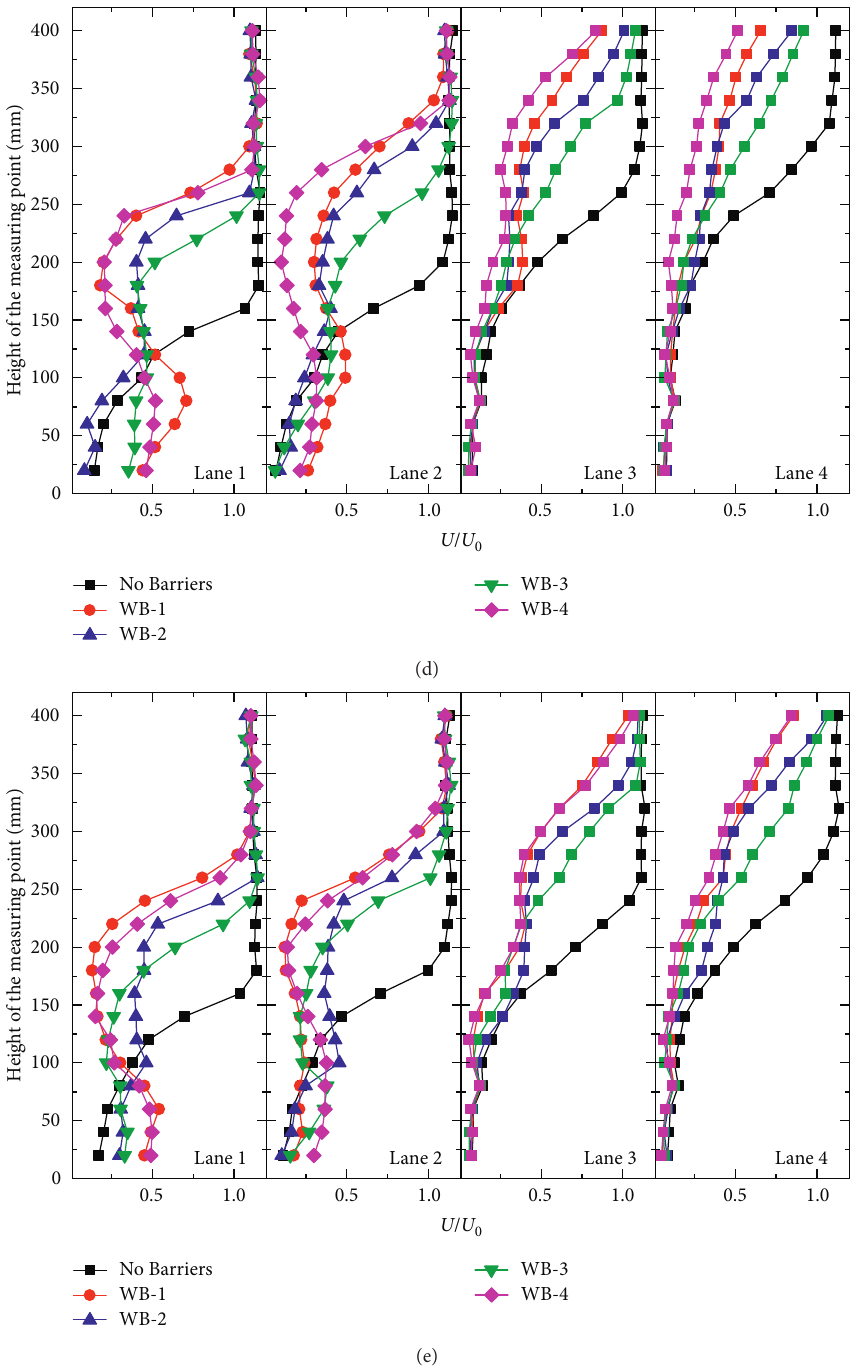
Figure 12: Wind profiles above the bridge deck at different longitudinal positions: wind profiles at (a) 0.5D, (b) 0.75D, (c) 1D, (d) 1.5D, and (e) 2